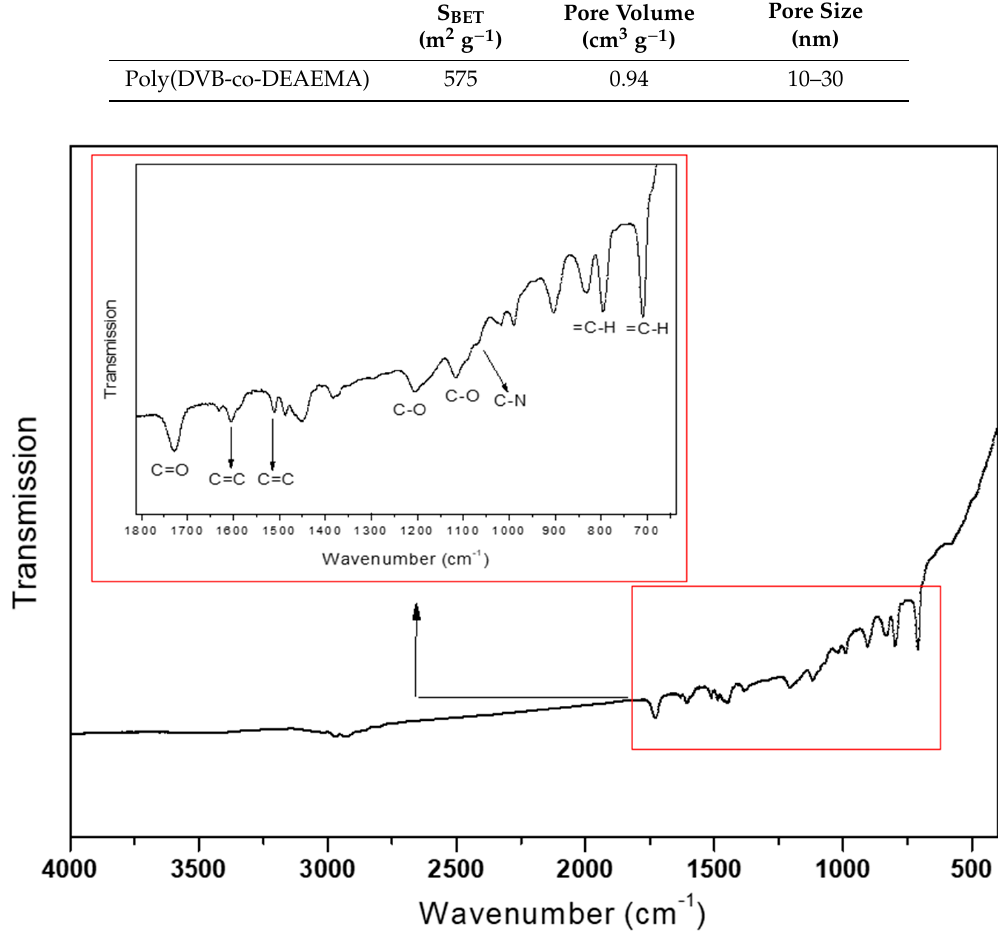
Figure 4. FTIR spectra of poly(DEAEMA-co-DVB) microspheres.